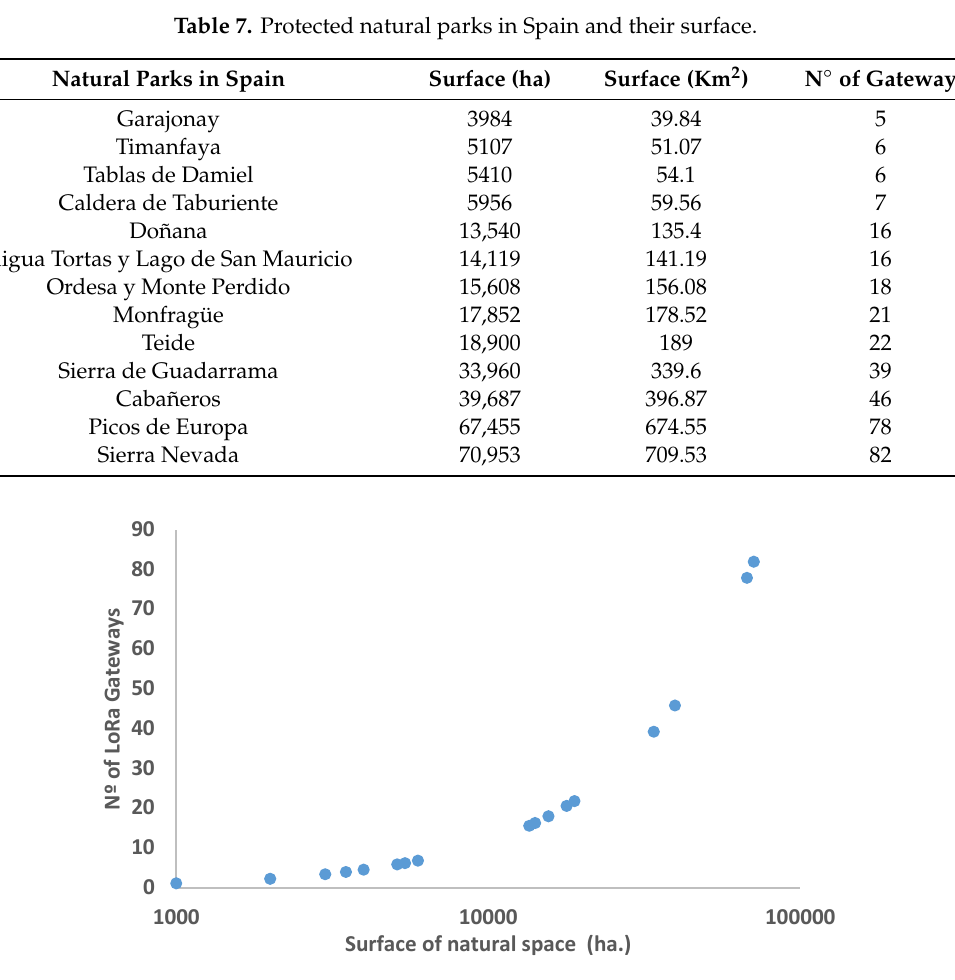
Figure 26. Required gateways as a function of the surface.